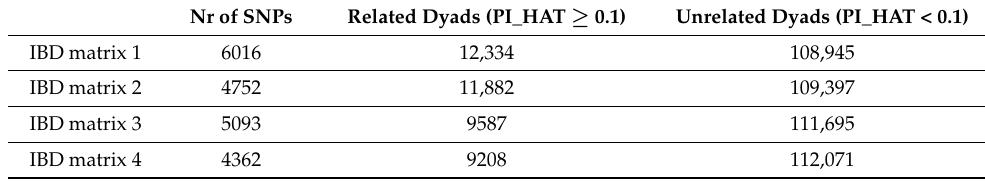
Table 1. Number of related and unrelated dyads in four distinct IBD matrices. Nr of